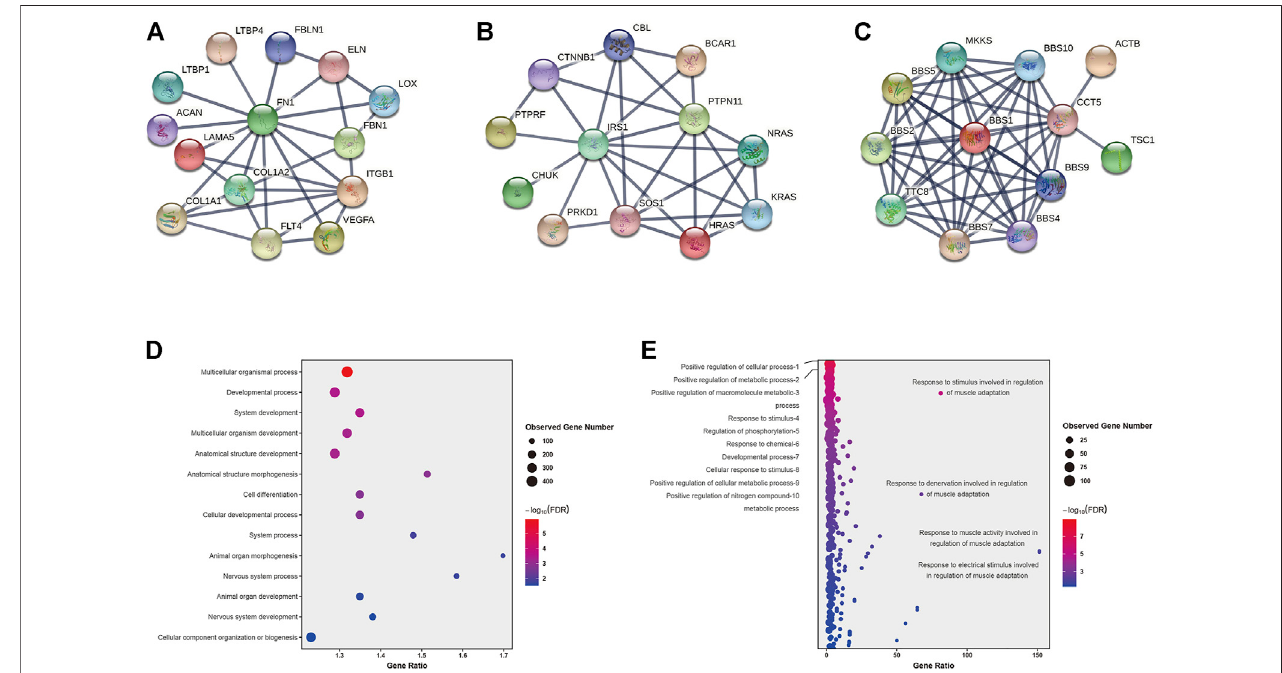
FIGURE 3 | Protein interactions and Genetic causes of CHD identi fi ed by WES. (A – C) : protein interactions of gene FN1 , IRS1 , and CCT5 . (D – E) : Enriched biological processes of 886 genes (D) set and 86 genes (E) set.